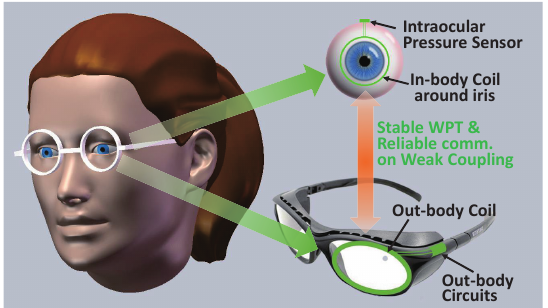
Figure 1. Inductive wireless link of the implantable sensor system for glaucoma